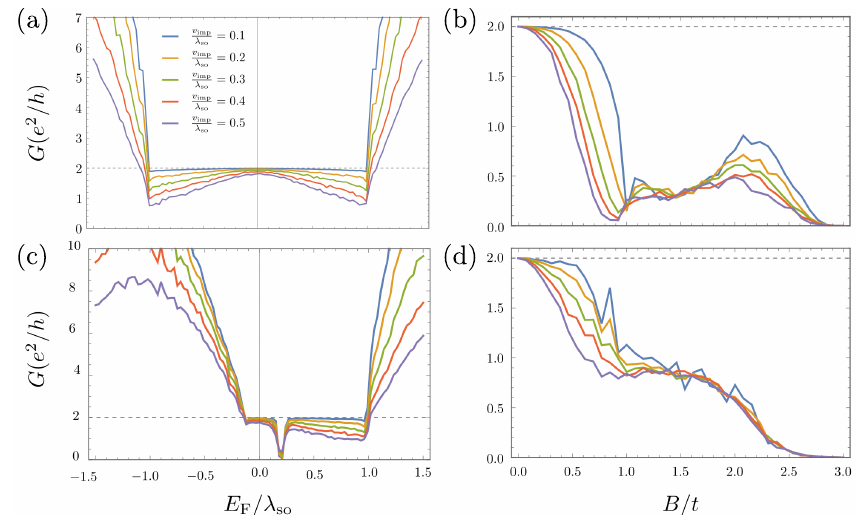
Figure 6: Linear conductance for the Kane-Mele model as a function of the Fermi energy with B = 0.25 t (left panels) and as a function of the Zee- = 0.0 (right panels) with different disorder strengths man energy B / t with E F /λ = 0.1,0.2,0.3,0.4,0.5. In the top panels, the calculations are performed v imp so = 0.0, while for the bottom panels λ = 0.15 t . All conductance calculations for λ R R are the result of the average over 100 realizations in a disordered slab of length 150 a 0